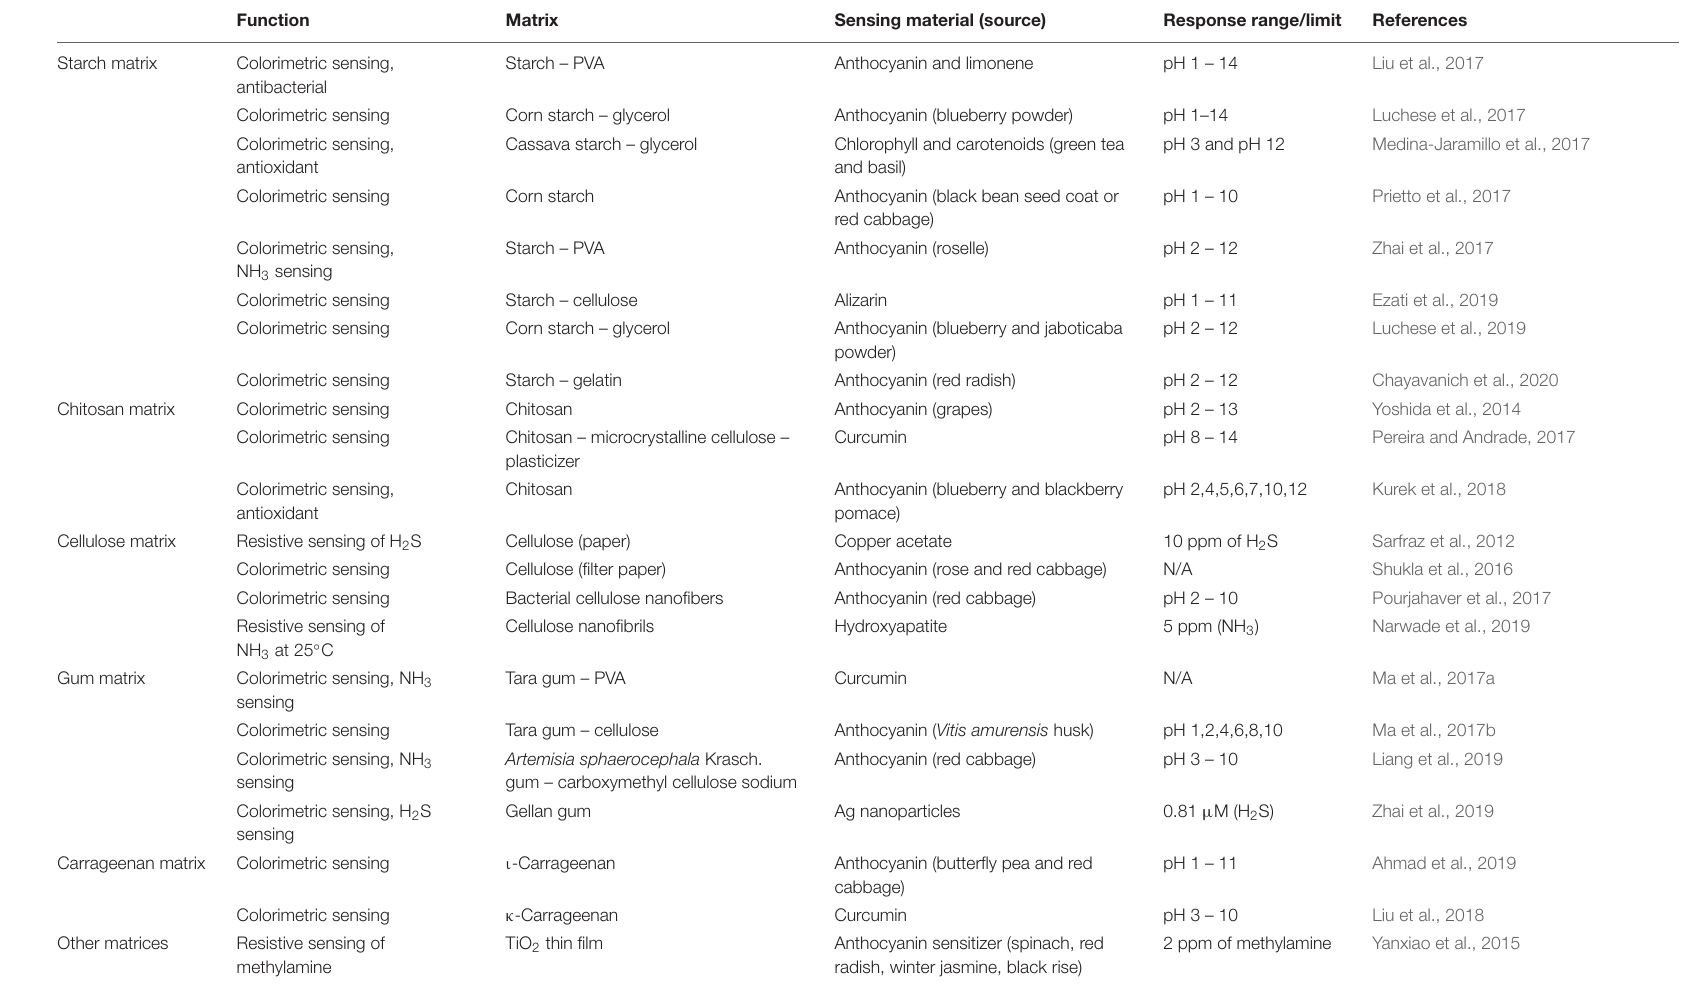
TABLE 4 | Bio-based sensors developed for food